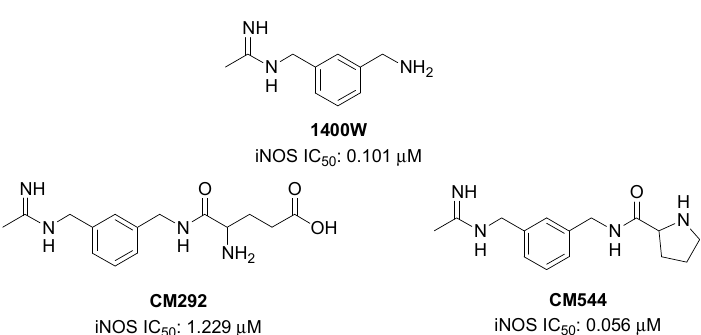
Figure 1. Chemical structure of the evaluated inducible nitric oxide synthase (iNOS) inhibitors.